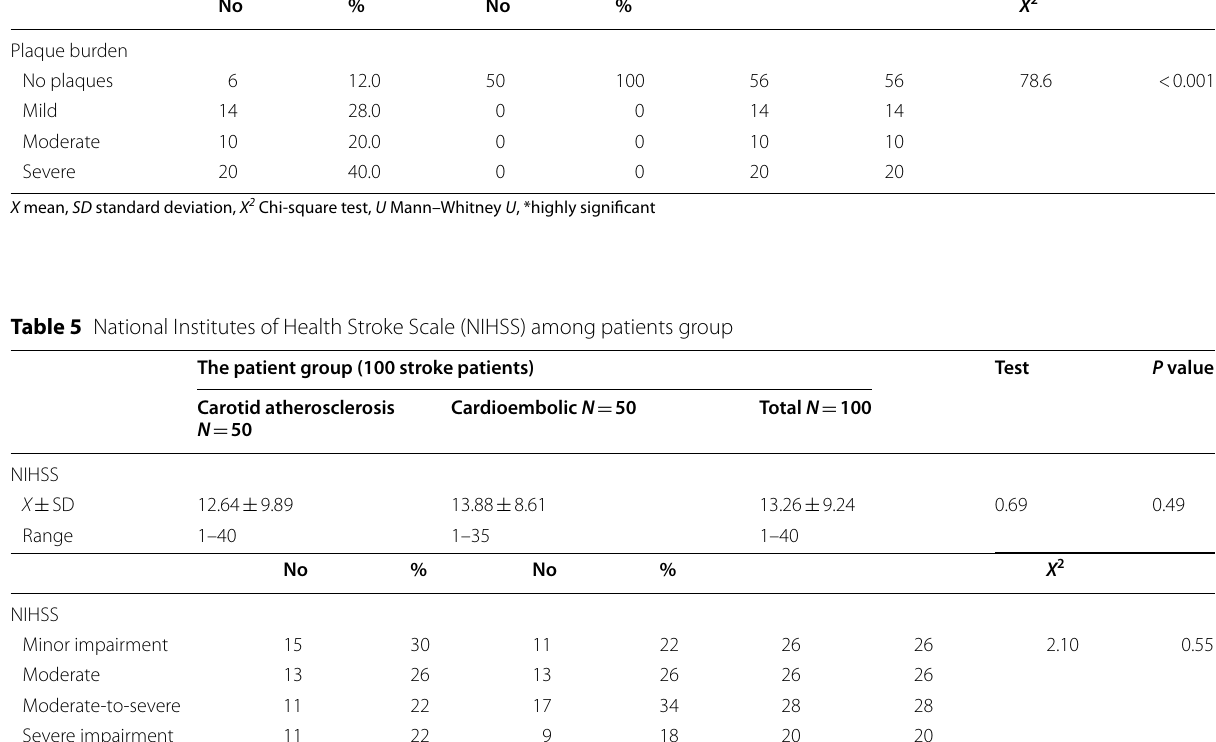
X mean, SD standard deviation, X 2 Chi‑square